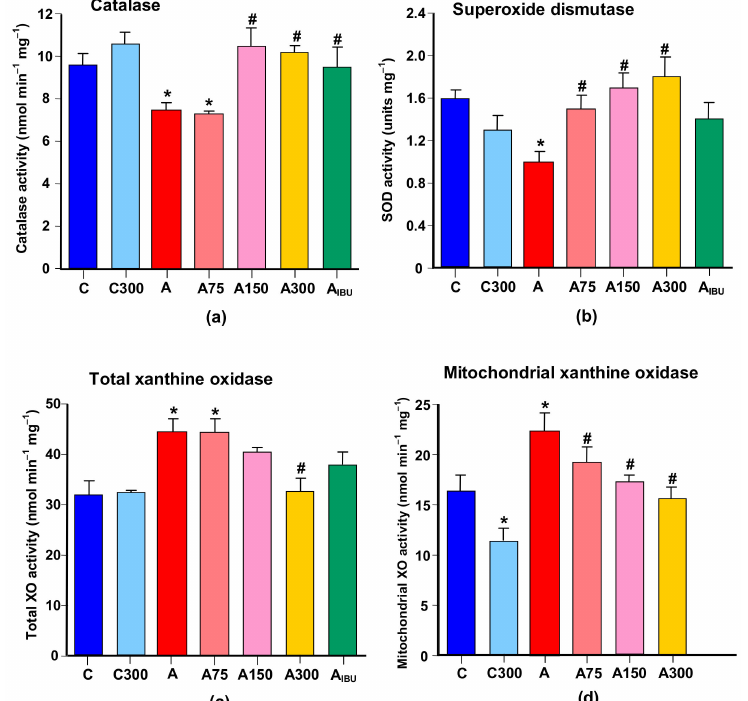
Figure 4. E ff ects of MeJA treatment on enzymes linked to the oxidative homeostasis. ( a ) Catalase; ( b ) superoxide dismutase; ( c ) total xanthine oxidase; ( d ) mitochondrial xanthine oxidase. Abbreviations: C, controls; C300, controls treated with 300 mg / kg MeJA; A, arthritic rats; A75, A150 and A300, arthritic rats treated with 75, 150 and 300 mg / kg MeJA, respectively; A IBU , arthritic rats treated with 30 mg / kg ibuprofen. Data are the means ± standard errors of the mean of five animals for each experimental condition. Statistical analysis: ANOVA one-way with Newman–Keuls post-hoc testing. * p < 0.05, di ff erent from the controls (C); # p < 0.05, di ff erent from non-treated arthritic rats